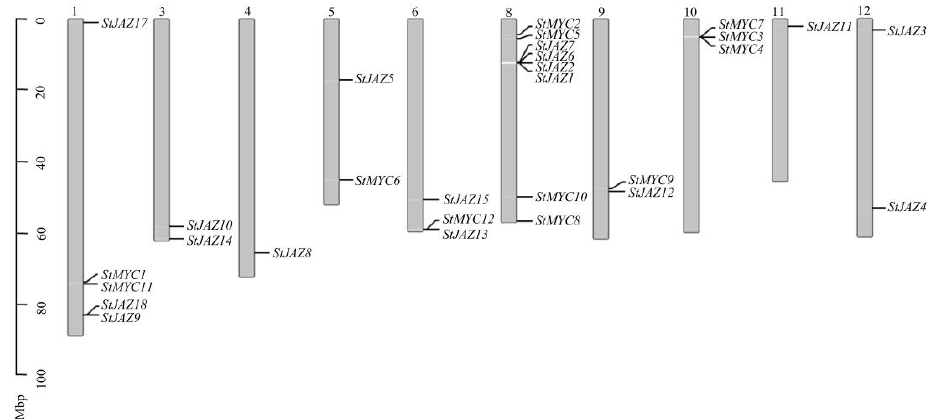
Figure 1. Genomic distributions of StJAZ and StMYC genes on 10 potato chromosomes (chromosomes are represented by bars, with chromosome numbers displayed at the top of the bars and gene names listed on the right. The relative chromosomal position of each gene is represented by the unit Mbp and marked on the black line on the left).